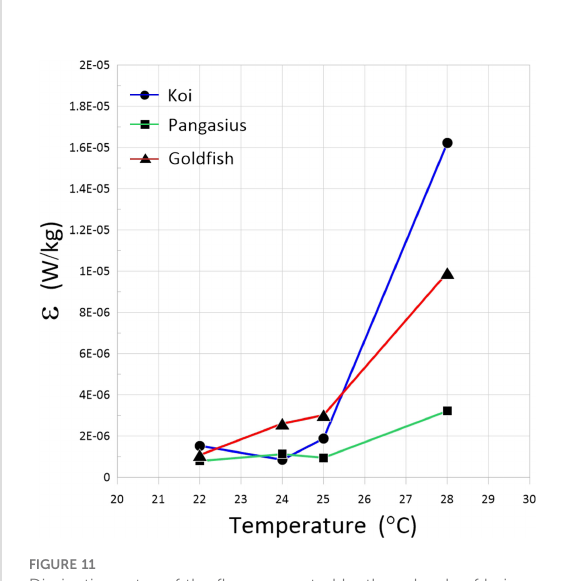
FIGURE 11 Dissipation rates of the fl ow generated by the schools of koi, pangasius, and gold fi sh as a function of water